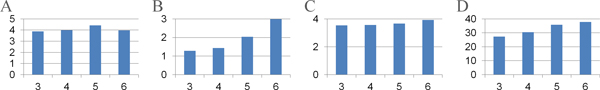
Evaluation of the functional, splicing, transcriptional, and protein complex homogeneity of co-splicing clusters with different recurrences. Four types of databases are used: (A) Gene Ontology for functional enrichment, (B) SpliceAid2 database for splicing enrichment, (C) ENCODE database for transcriptional and epigenetic enrichment, and (D) CORUM database for protein complex enrichment. The x-axis is network recurrence and y-axis is enrichment fold ratio, calculated by dividing the percentage of enriched clusters by the percentage of enriched random clusters.